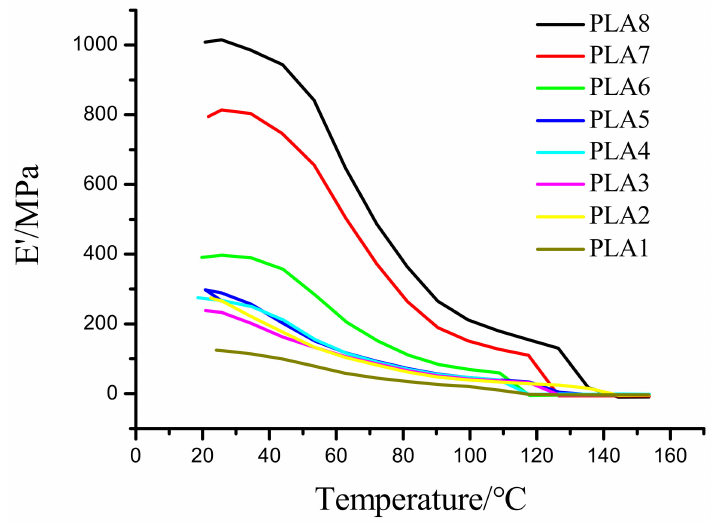
Figure 2. Analysis of Storage Modulus of BSP / PLA Films. Temperature / storage modulus